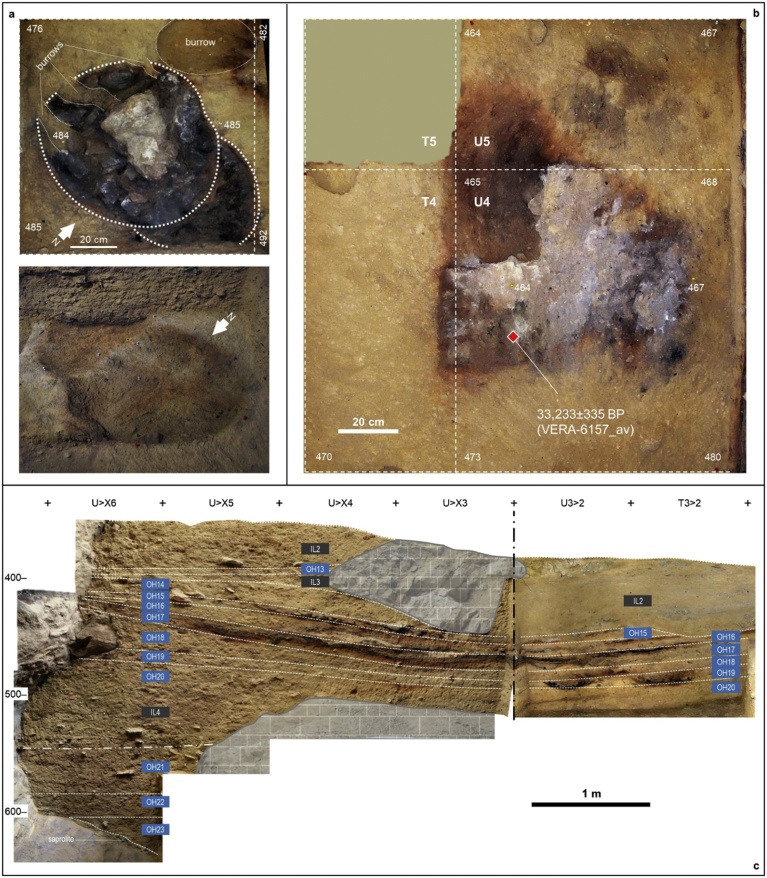
The basal, Mousterian and Aurignacian sections of the La Boja sequence. Elevations are in cm below datum. a. The OH19 double hearth in grid unit T3 at exposure of the feature’s top (above, orthorectified plan view) and base (below, oblique view from the opposite angle). b. Orthorectified plan view of the OH19 hearth in grid unit U4; the provenience of the sample that established this horizon’s radiocarbon age is indicated by the red diamond. c. Stratigraphic cross-sections representing the basal parts of the sequence extant at the end of the 2014 field season; the preservation of intact hearths and/or extensive lenses of anthropized sediment allows sub-centimeter discrimination of occupation floors (OH) separated by intermediate levels (IL); the latter are sterile or only contain post-depositionally intruded items (OH21-23 are Mousterian, OH15-20 are Aurignacian, OH13-OH14 are Early Gravettian).